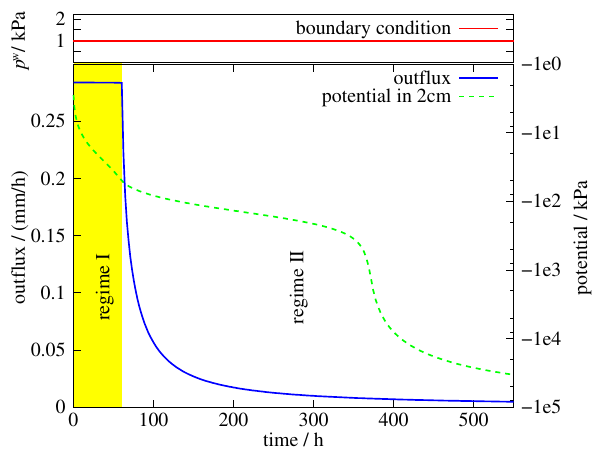
Fig. 2. Water flux at the upper boundary j w and potential in 2cm depth of the onestep measurement. Notice that p w jumps from equi- librium to 1kPa at t =